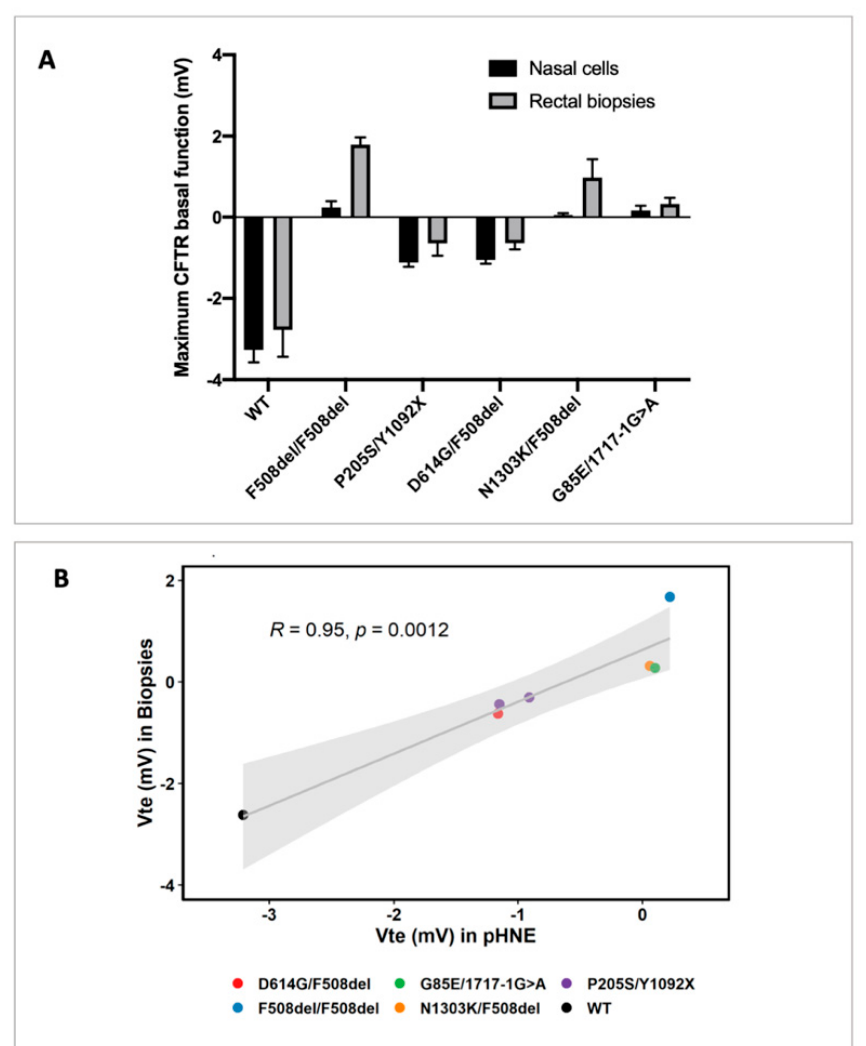
Figure 2. Correlation between maximum activation of CFTR-mediated Cl − secretion in pHNEs and rectal biopsies from the same individual. ( A ) Summary of CFTR-mediated Cl − secretion in rectal biopsies and pHNE cells in one healthy control and five different individuals with CF. CFTR basal function in pHNEs correspond to the differences in Vte after IBMX/Fsk stimulation. CFTR basal function in rectal biopsies is expressed by the difference in Vte upon IBMX/Fsk+IBMX/Fsk/CCH stimulation. Data is represented as the mean of three different experiments for each model ± SD. ( B ) Correlation of CFTR- mediated Cl − secretion stimulated by IBMX/Fsk in pHNEs and IBMX/Fsk+ IBMX/Fsk/CCH in rectal biopsies (Vte I/F+I/F/C ) from the same individual (Pearson’s R = 0–95, p -value = 0.0012). The grey line represents the linear regression of the data. The grey area represents the 95% confidence interval.